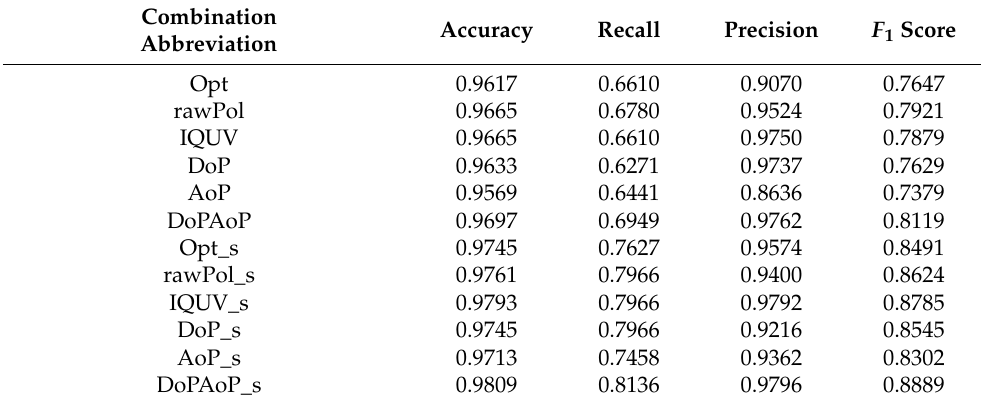
Table 4. Random forest classifier results for different combinations related to Q1, Q2 and Q3.